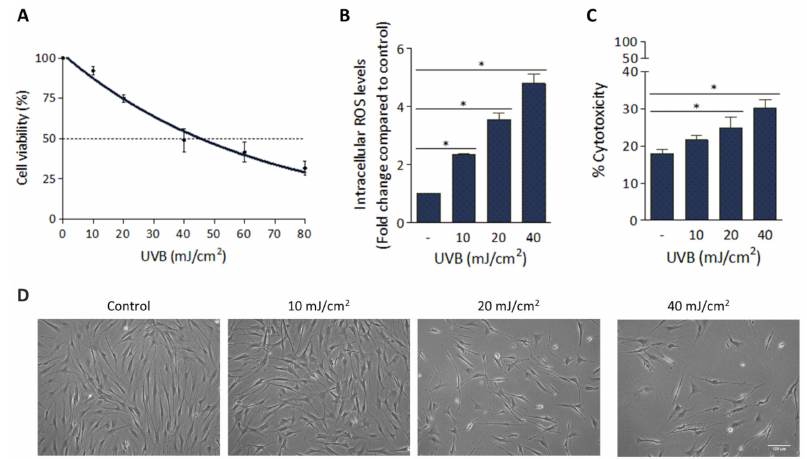
Figure 1. Dose-dependent effect of UVB radiation on hFFs. ( A ) Cells were exposed to 0–80 mJ/cm 2 UVB radiation, and the percentage of viable cells was measured 48 h after exposure. ( B ) ROS generation was induced by UVB radiation (10, 20 and 40 mJ/cm 2 ) and measured at 1 h. Results were normalized to controls (non-irradiated cells). ( C ) Percentage of cytotoxicity as measured by LDH levels in the culture medium 48 h post-irradiation. ( D ) Phase-contrast images of HFFs 48 h after UVB irradiation (scale bar: 100 µ m). Data are expressed as mean ± SD. * p < 0.05 compared to controls (non-irradiated